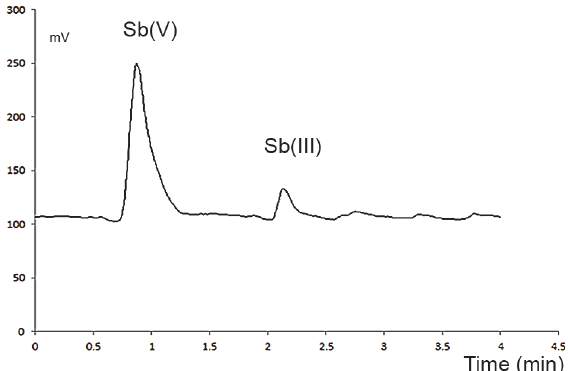
Figure 3. Chromatogram of blood plasma incubated with 200 ng mL − 1 Sb(V) and 0.1 mol L − 1 EDTA. Partial reduction of Sb(V) to Sb(III) can be observed. * No trimethyl-Sb(V) was detected. * Incubation was performed in triplicate using collection tubes from single donor ’ s blood .